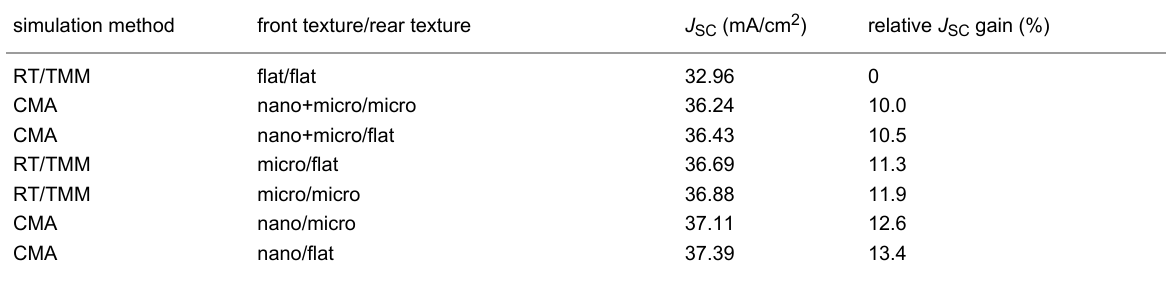
Table 2: Simulated J SC of the encapsulated solar cells with different